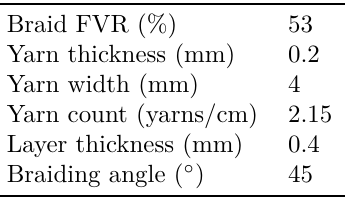
Table 3. Yarn and braiding geometry of the test specimens.